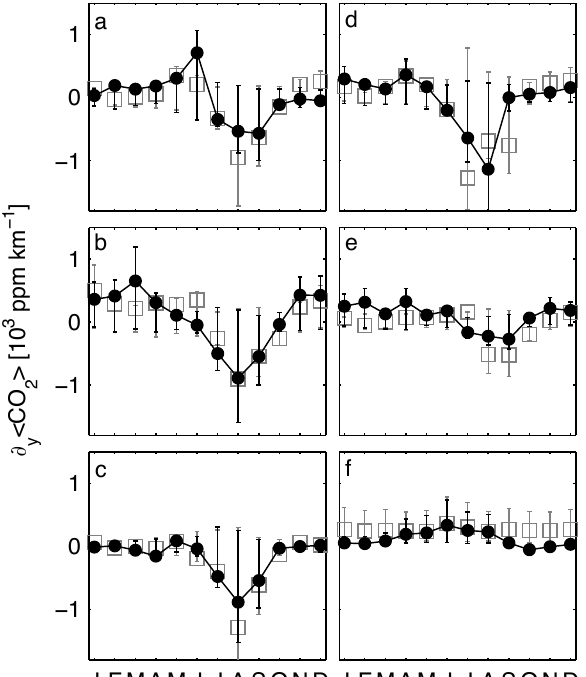
Fig. 19. Estimated \ ∂ y h CO 2 i at six TCCON sites in AM2 (black circles) and in TM5 (gray squares) using identical surface fluxes. (a) Bialystok, Poland (b) Orleans, France (c) Park Falls, USA (d) Lamont, USA (e) Pasadena, USA (f) Lauder, New Zealand. The estimated gradients generally agree when the two models are driven with identical surface fluxes despite different